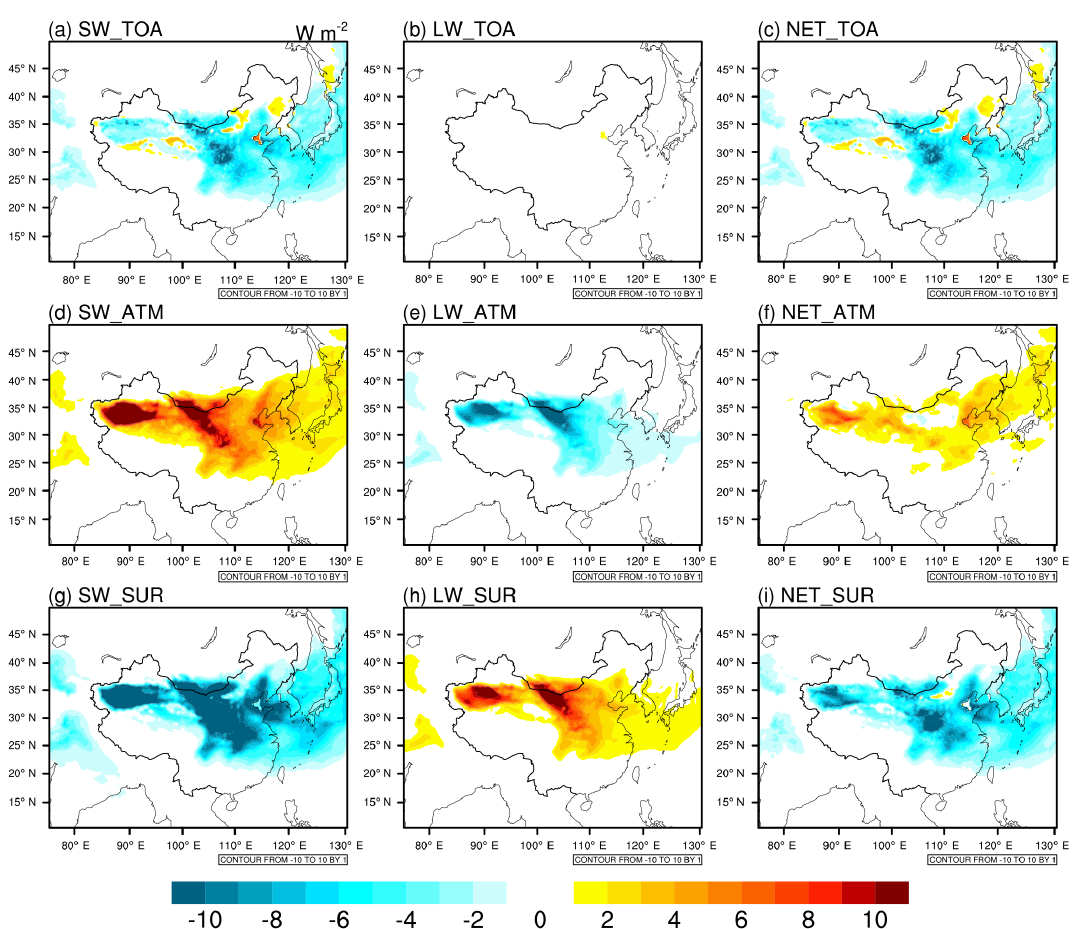
Figure 15. Spatial distributions of the direct radiative forcing by dust for SW, LW, and net (SW + LW) radiation (W × m − 2 ) at the TOA (top panels), SUR (bottom panels), and in the ATM (middle panels) average during the simulation period under all-sky conditions based on the WRF-Chem model. For direct radiative forcing by dust, the positive values represent downward radiative fluxes at the TOA and SUR and represent radiative warming in the